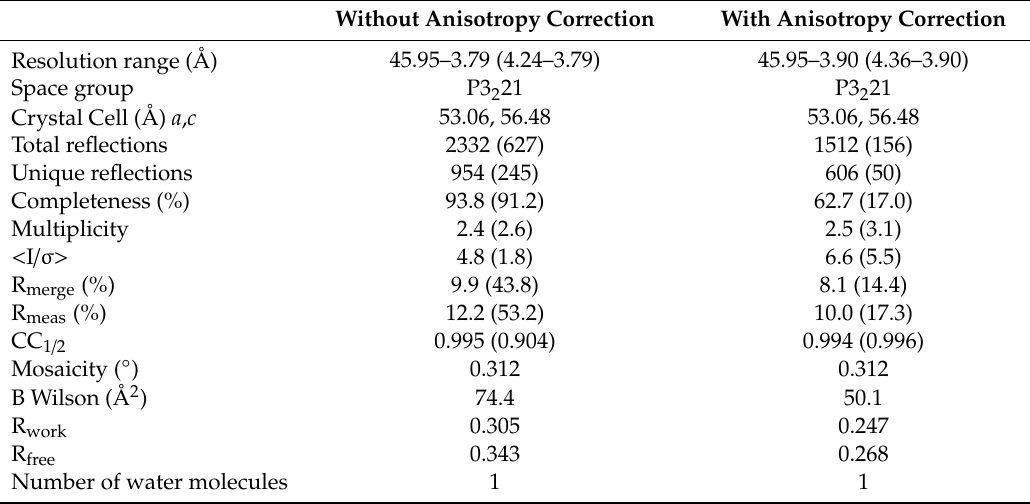
Table 1. Crystallographic parameters obtained for datasets with and without anisotropy correction. Values in parentheses are for the highest resolution